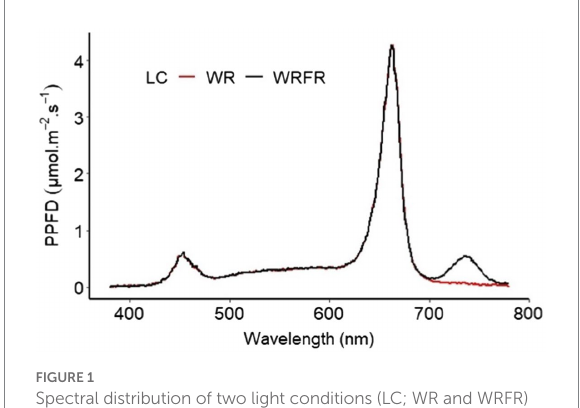
FIGURE 1 Spectral distribution of two light conditions (LC; WR and WRFR) provided by white (W), red (R), and far-red (FR) light-emitting diodes (LEDs).